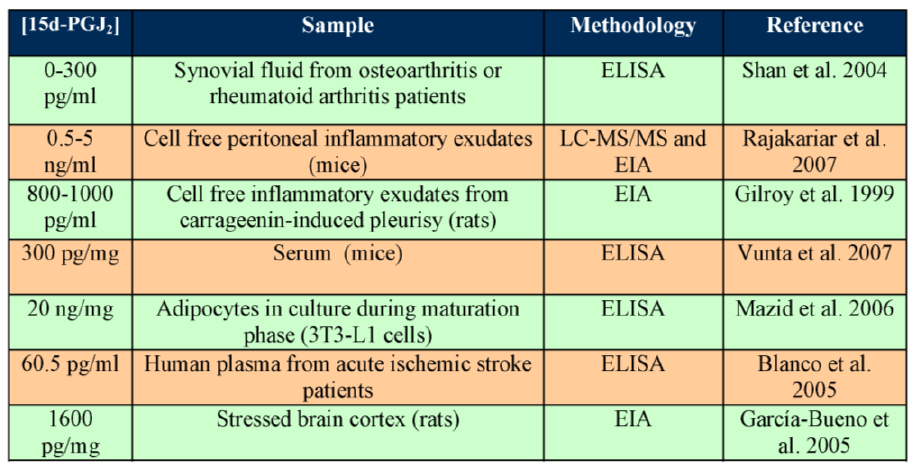
FIGURE 5. Concentrations of 15d-PGJ 2 measured in different experimental systems and in